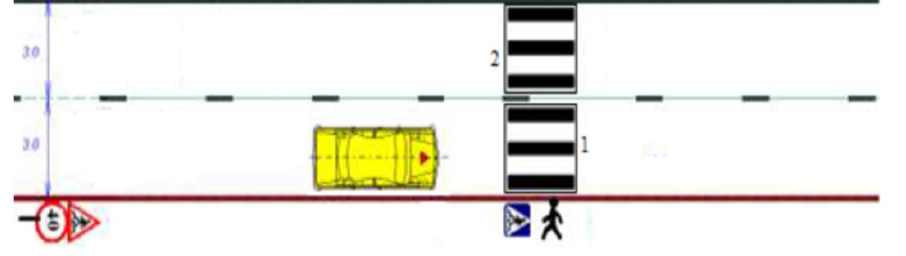
Fig. 10. The layout of the pedestrian and the car on an unregulated pedestrian crossing